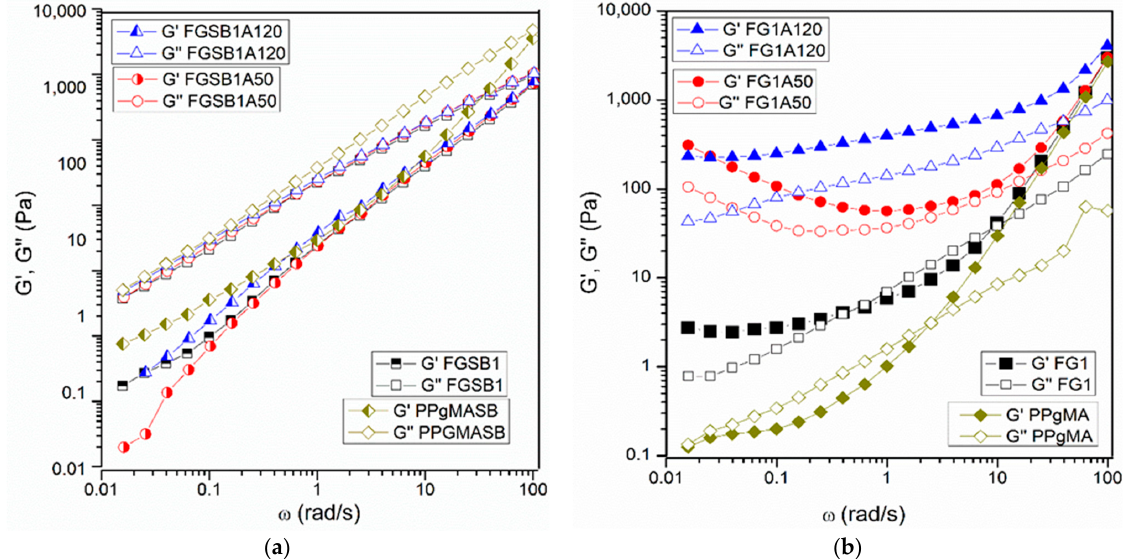
Figure 8. Storage (G (cid:48) ) and loss (G (cid:48)(cid:48) ) modulus of PPgMASB and its derivatives (FGSB1, FGSB1A50, FGSB1A120) ( a ); PPgMA and its derivatives (FG1, FG1A50, FG1A120) ( b ) at various angular frequen- cies ( ω , rad/s) measured at 160 ◦